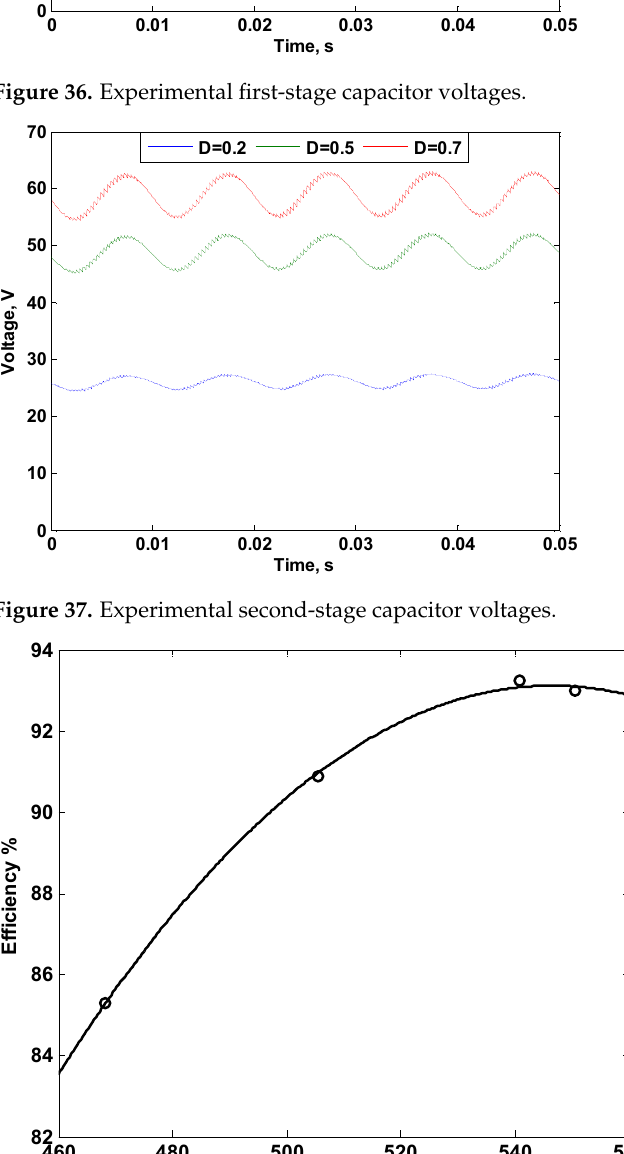
Figure 39. Experimental output voltages considering a closed-loop control. 6. Conclusions In this paper, a proposed multiple-source DC–DC buck-boost converter has been presented. The suggested DC–DC converter has increased reliability due to its depend- ence on more than one stage and more than one source. The performance of this con- verter has been theoretically studied using PSIM software. The study has been carried out to take different operating conditions into consideration ranging from healthy to faulty conditions. Different loads have been adopted in the study such as resistive– inductive and battery loads. Different sources have been used as exciting supplies such as DC sources and PV panels. Moreover, closed-loop voltage control and closed-loop cur- rent control have been implemented, and a good performance has been achieved con- sidering healthy and faulty conditions. It has been proven that the suggested converter can be supplied from only one source with a slight modification. This point has been